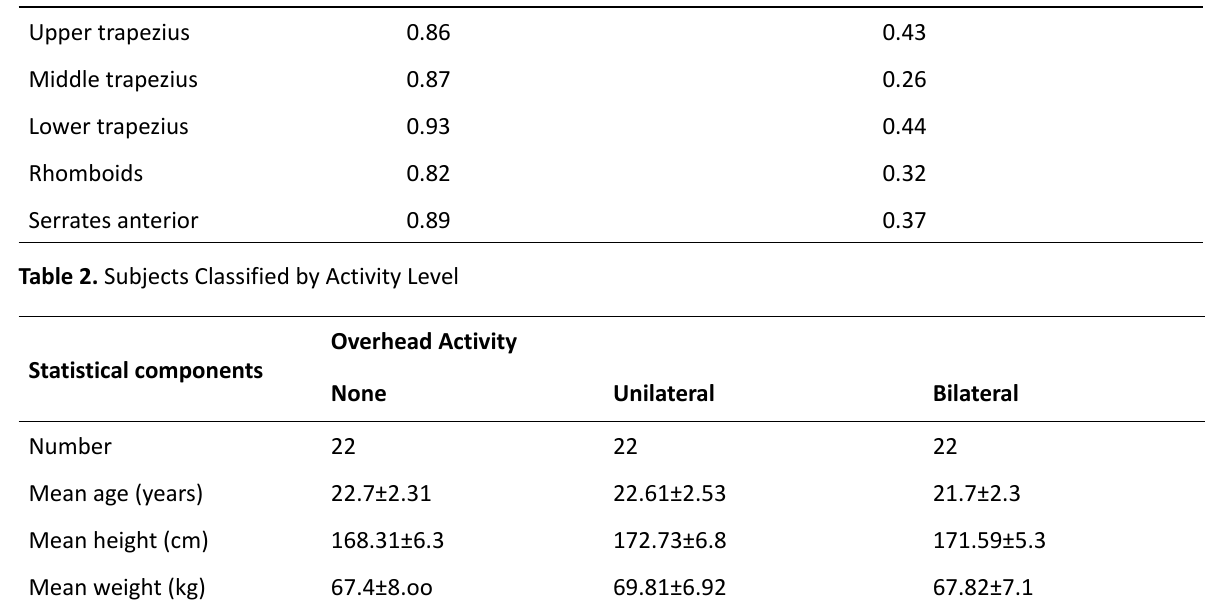
Table 1. Reliability Analysis for the Pilot Study